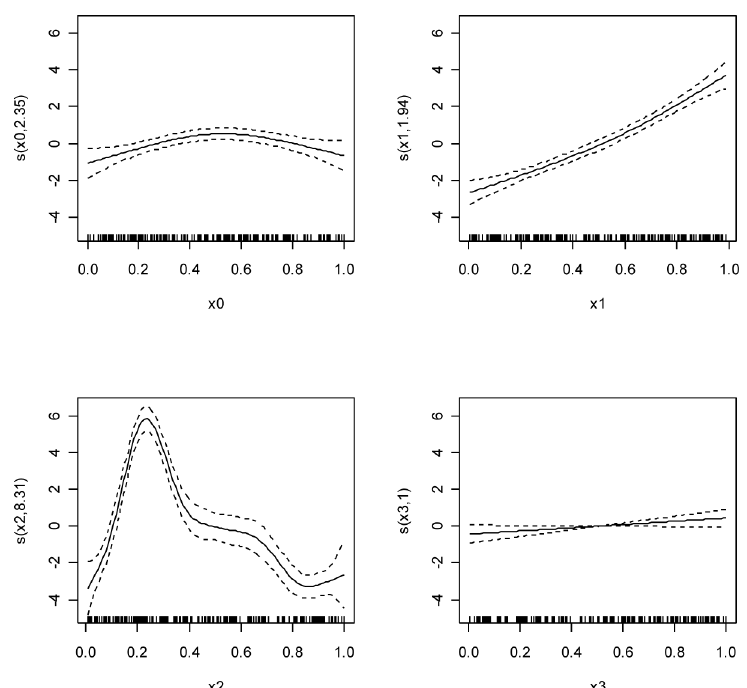
Figure 1. Spline example plots obtained using exercise data from